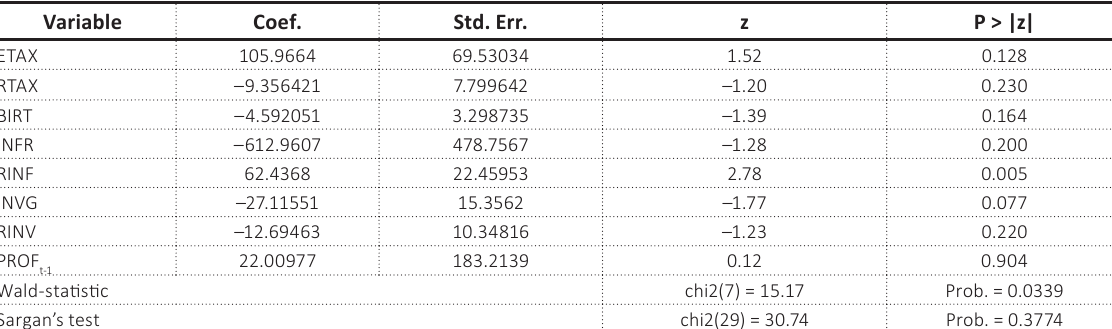
Table 6. Dynamic panel regression results of the primary